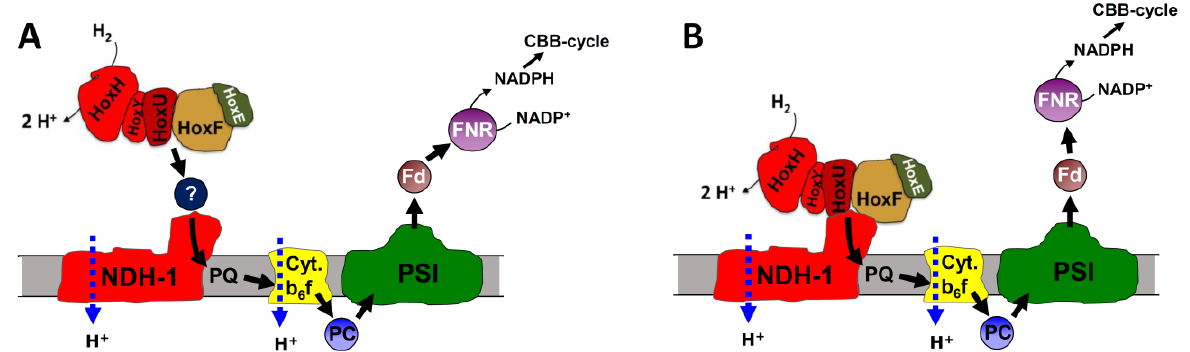
Figure 9. Scheme of the two possible scenarios suggested by our results. ( A ) The bidirectional hydrogenase might either reduce an unknown mediator that needs to have a lower redox potential as ferredoxin 1 or ( B ) it directly binds to the NDH-1 complex and H 2 oxidation is directly linked to PQ reduction.